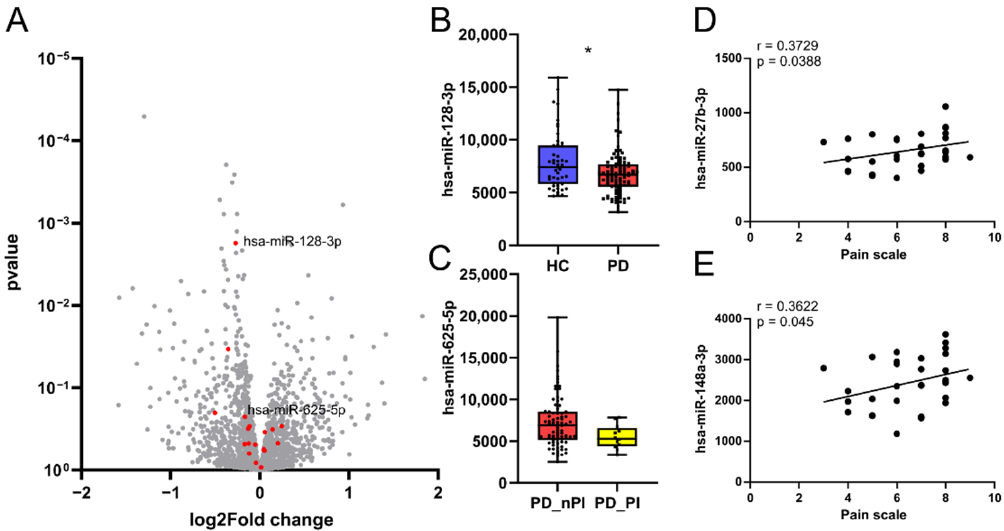
Figure 4. CholinomiRs are related to pain and form a specific FMS signature. Identified CholinomiRs may positively correlate with pain intensity. ( A ) FMS blood levels of hsa-miR-27b-3p ( p = 0.039; padj = 0.530) and ( B ) hsa-miR.148a-3p (* p = 0.045; padj. = 0.563) increased with the mean pain level experienced in the past 6 months, but all 19 CholinomiRs failed to pass post-correction for multiple testing. Spearman correlation test with Holm–Sidak post correction. ( C ) Volcano plot of miRs in PD versus HC with no DE miRs. FMS CholinomiRs present in the PD dataset are marked in red. ( D , E ) Only comparing CPM expression levels of FMS CholinomiRs in PD revealed trends for lower hsa-miR-128-3p ( p = 0.028; padj = 0.364) and within PD patients with pain related impairments an hsa-625-5p downregulation ( p = 0.052; padj = 0.678). Mann–Whitney U tests with Holm–Sidak post correction. Abbreviations: CPM, counts per million; FMS, fibromyalgia syndrome; HC, healthy control; PD, Parkinson’s disease; PD_nPI, Parkinson’s disease without pain-related daily life im- pairment; PD_PI, Parkinson’s disease with pain-related daily life impairment.